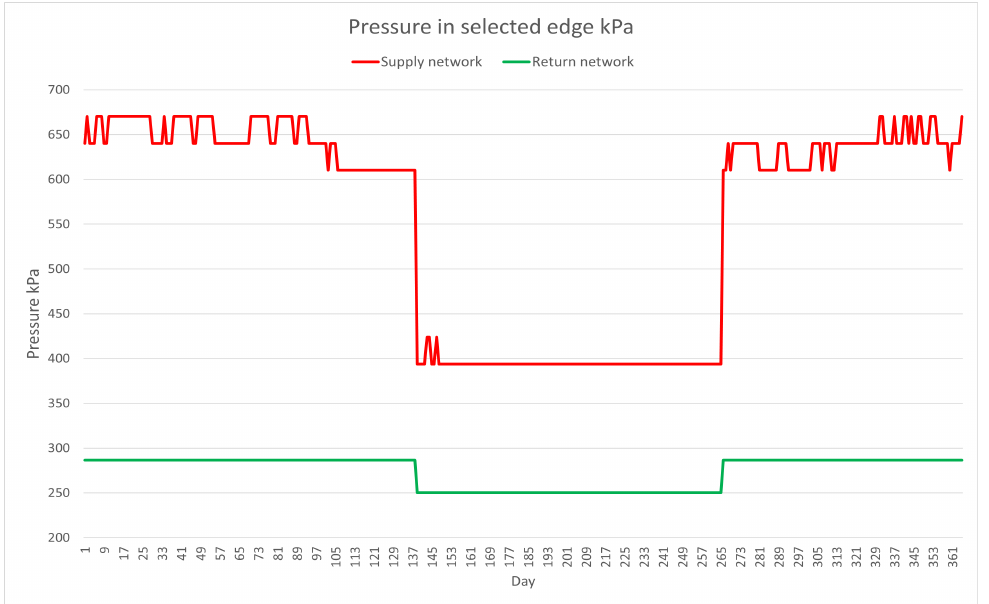
Figure 5. Pressures in the selected edge in the range of the year.